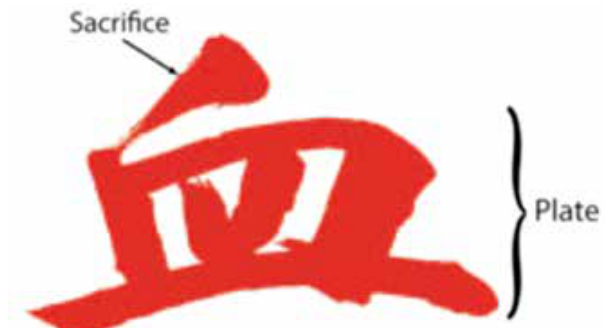
Figure 1. A diagonal stroke over the symbol of the plate signifies “ the sacrifice placed on the plate